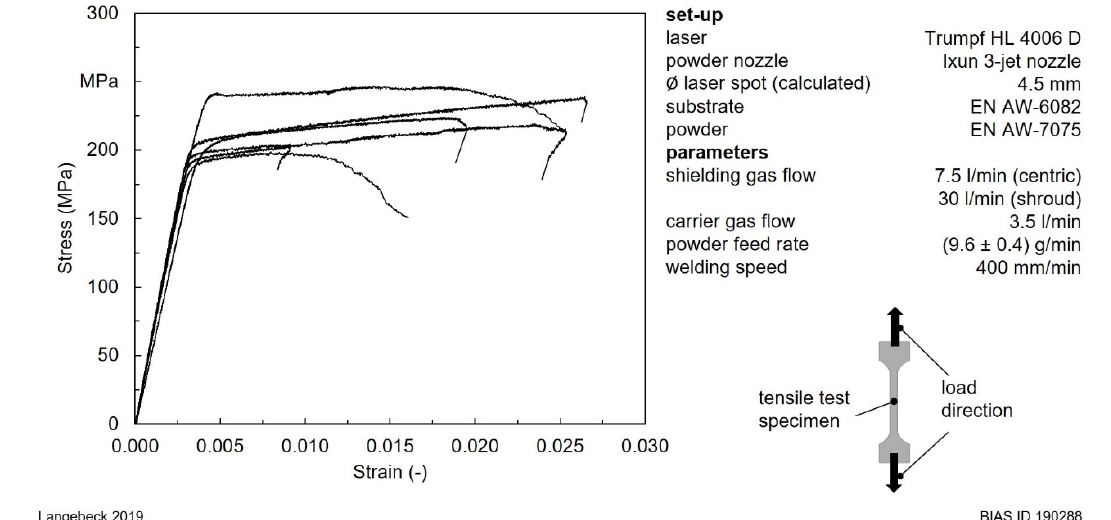
Figure 5. Results of tensile tests for additively manufactured specimens made of EN AW-7075.